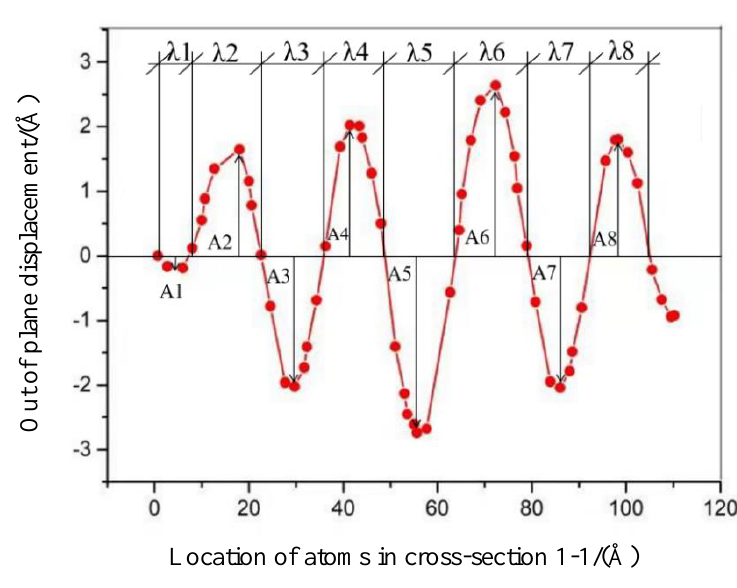
Figure 3. Wrinkling shape in cross-section 1–1 of Figure 1 (BC1 with an applied shear speed of 0.1 Å / ps and a total shear displacement of 10 Å ).